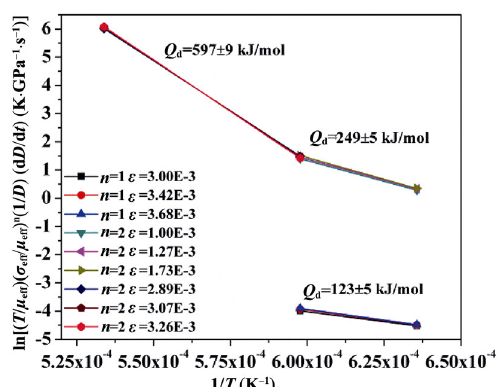
Fig. 9 Apparent activation energy ( Q d ) as a function of temperature, calculated within different n values. The slope of the straight lines is – Q d / R